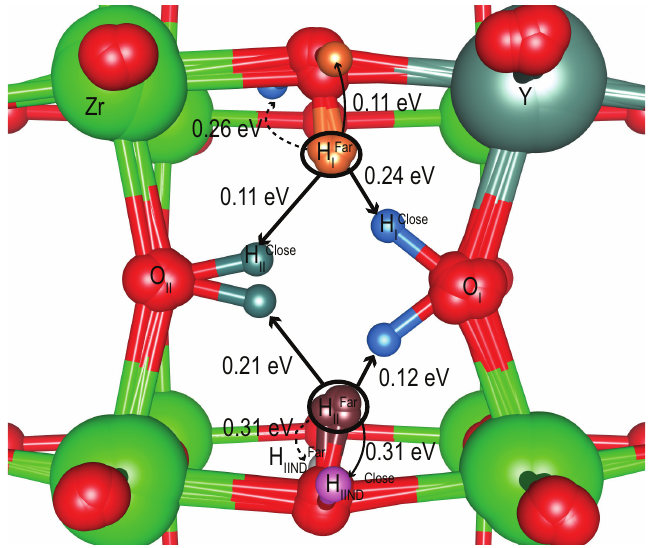
Figure 1. The lowest-energy proton–tuple in yttrium-doped barium zirconate is shown superimposed upon minima that are one proton move away from the lowest energy structure. The arrows highlight the move. The barrier to the move is listed by the arrows. The two protons in the lowest energy structure are each surrounded by an ellipse. Proton sites are labeled by color. The same notation as in our earlier work [10,21] is used.